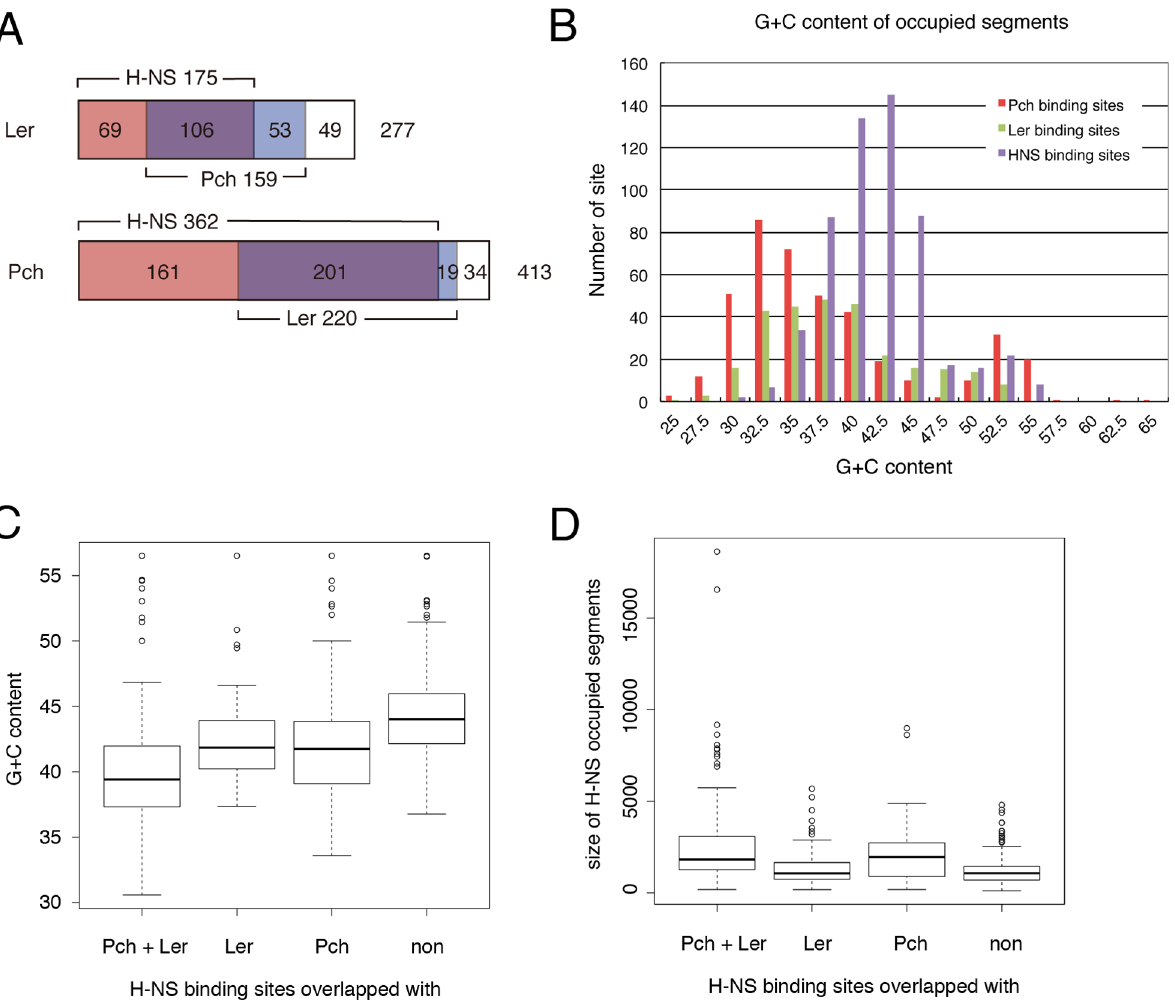
Fig 5. Features of binding sites for Pch and Ler. A. Overlapping of binding sites. Binding sites for Ler and Pch are classified by overlapping with H-NS bindings and Pch or Ler bindings. B. G+C contents of binding sites for H-NS, Pch, and Ler. Distributions of a number of binding sites with various ranges of G +C contents are shown. For example, 25 indicates that the G+C content of the binding site sequence is less than 25%. C. Distributions of the G+C content of the binding site for H-NS with or without Pch- and/or Ler-binding sites. Box plots represent medians (horizontal lines), the upper and lower quartile values (boxes), and the most extreme data points within 1.5 interquartile ranges (whiskers). D. Distributions of the sizes of the binding sites for H-NS with or without Pch- and/or Ler-binding